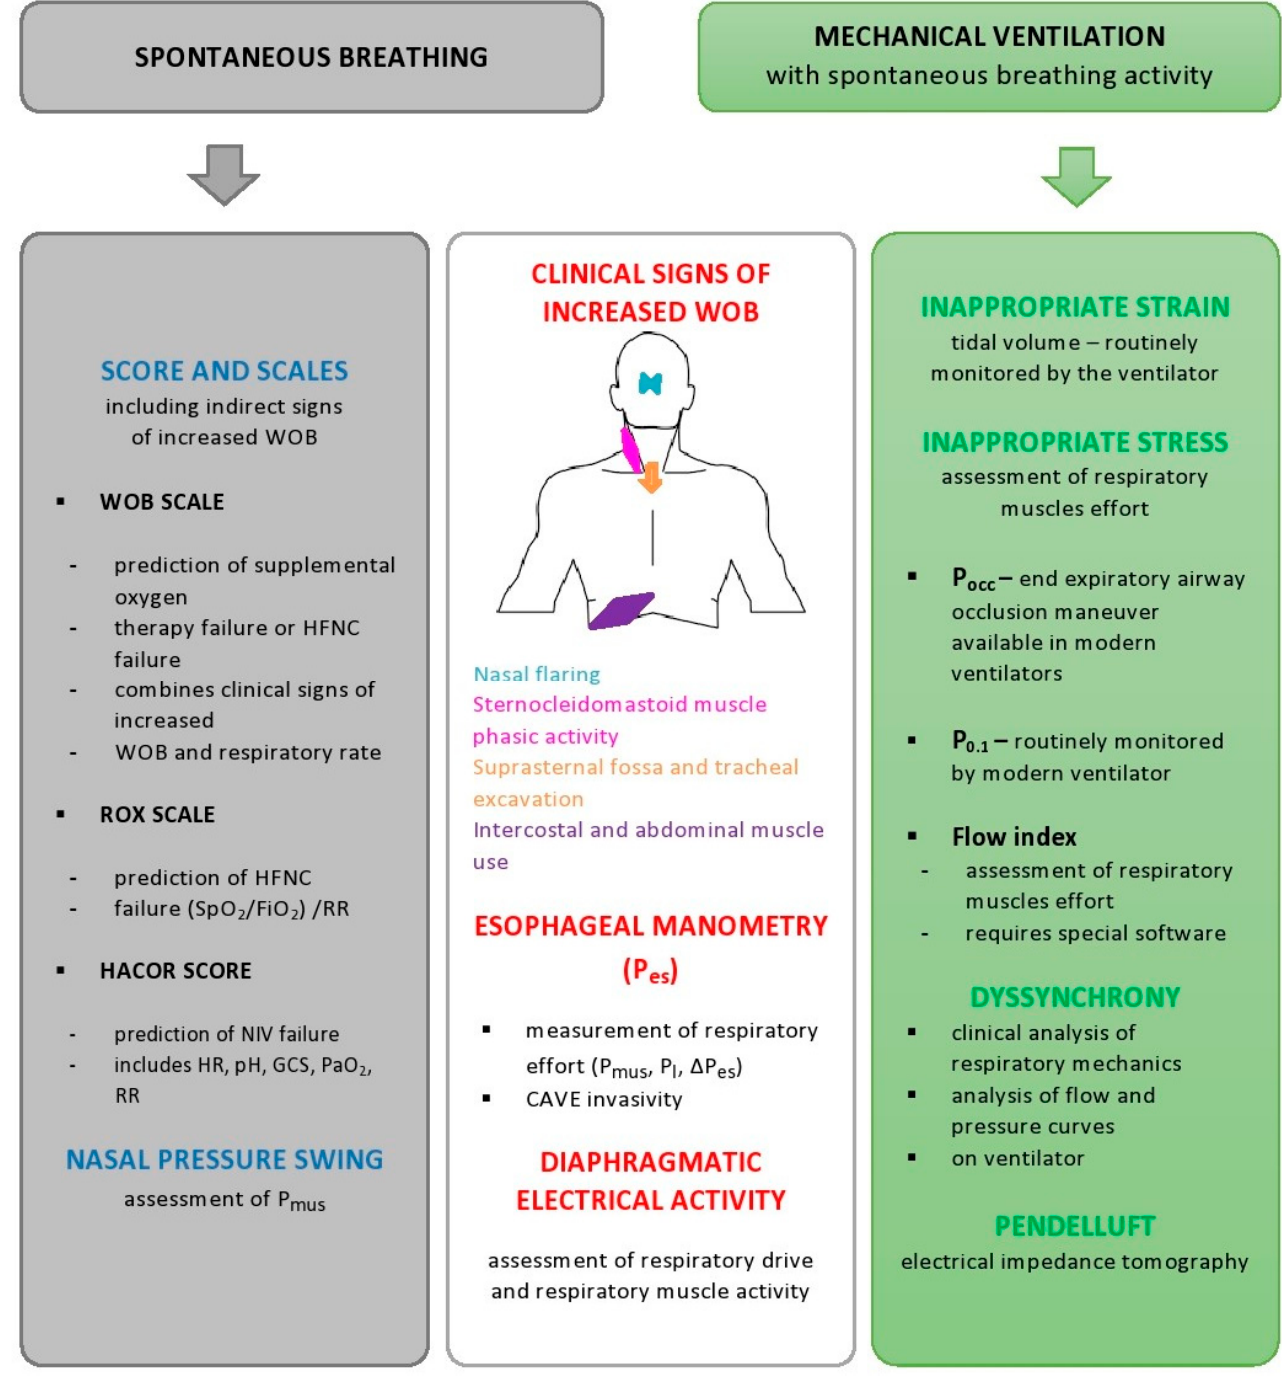
Figure 2. Noninvasive or minimally invasive bedside tools for detection of potentially injurious respiratory effort. Blue square—methods of indirect detection of vigorous spontaneous effort